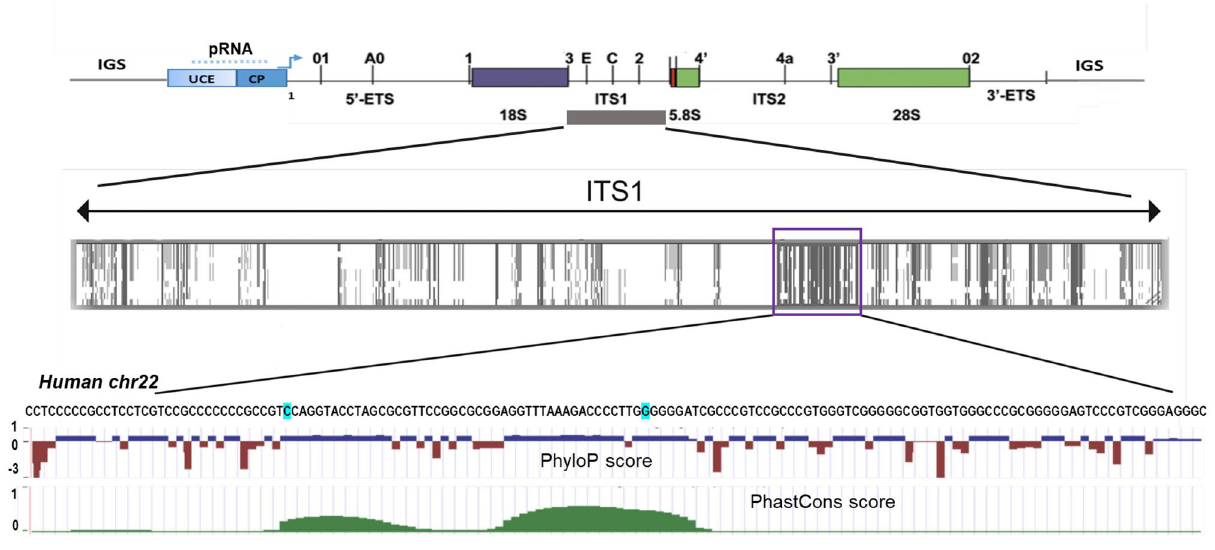
Figure 5. Human pre-rRNA processing and ITS1 and C-box similarity in mammals. Schematic presentation of the human RNA polymerase transcript—45Svpre-rRNA (upper panel), processing sites are marked as reviewed in Mullineux and Lafontaine 61 . UCE—upstream control element; CP—core promoter; IGS—an intergenic spacer; 5 ′ ETS and 3 ′ ETS—5 ′ and 3 ′ external transcribed spacers; ITS1 and ITS2—internal transcribed spacers 1 and 2. Conservation in mammals is indicated by shades of grey (a middle panel); C-box is shown in violet box. The C-box nucleotide sequence is shown for human chromosome 22 (this study; bottom panel); the locations of human variants (INDELs) in the C-box are highlighted in blue. C-box conservation by Phylop (brown and blue) and by PhastCons (green) from the Multiz alignment of 30 mammals is shown in the bottom panel